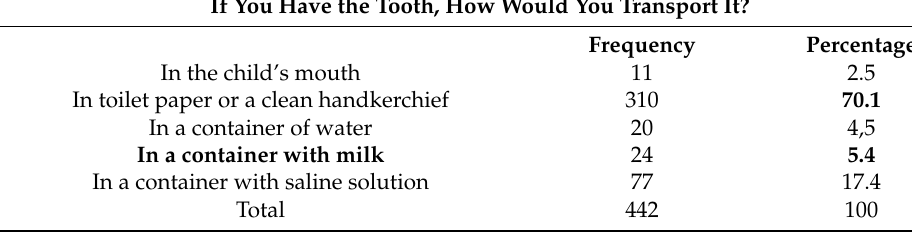
Table 4. Storage medium and transport.